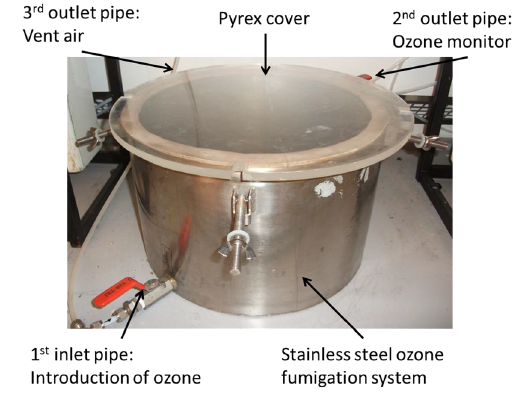
Figure 9. Ozone fumigation